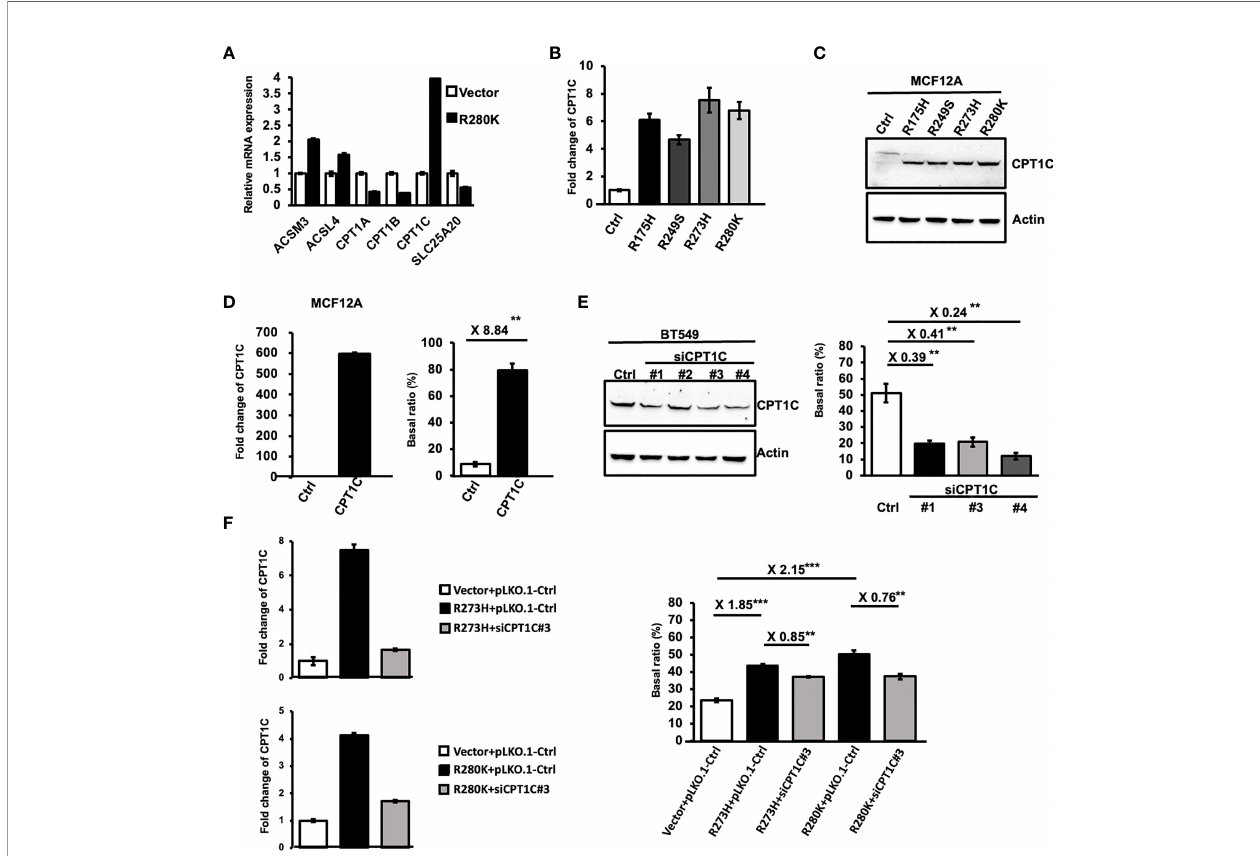
FIGURE 2 | Mutant p53 activates FAO activity through upregulating CPT1C. (A) The differential expression of lipid metabolism-related genes induced by mutant p53. The relative mRNA expression level of ACSM3 , ACSL4 , CPT1A , CPT1B , CPT1C , and SLC25A20 between control and MCF12A-p53 R280K cells were determined by Q-PCR (mean ± SD, n = 3). (B) The mRNA expression of CPT1C is upregulated by p53 hot-spot mutants. Relative mRNA expression of CPT1C between control cells and p53 mutant-MCF12A cells was determined by Q-PCR (mean ± SD, n = 3). (C) Protein expression of CPT1C is upregulated by p53 hot- spot mutants. The expressional levels of CPT1C and Actin in control (Ctrl) and mutant p53-bearing MCF12A cells were examined by Western Blotting. (D) The FAO activity is upregulated by CPT1C overexpression in mammary epithelial cells. Left: The expressional levels of CPT1C and Actin in control (Ctrl) and CPT1C- overexpressing MCF12A (CPT1C) cells were examined by Western Blotting. Right: The FAO activity of Ctrl and CPT1C cells was presented as a Basal ratio and shown as a bar graph (mean ± SD, n = 3). (E) The FAO activity is decreased by the knockdown of CPT1C in BLBC cells. Left: The expressional levels of CPT1C and Actin in control (Ctrl) and CPT1C-KD BT549 cells (siCPT1C#1, #3, and #4) were examined by Western Blotting. Right: The FAO activity of Ctrl and CPT1C cells was presented as a Basal ratio and shown as a bar graph (mean ± SD, n = 3). The two sides of the lines above the bars indicated the comparison of each KD clone to the control, and the value of fold changes with the asterisks representing signi fi cance was marked above the line. Data were analyzed by unpaired t-test. **p < 0.01. (F) Downregulating CPT1C expression interferes with p53 mutant-enhanced FAO activity. Left: The mRNA expressional level of CPT1C in control and CPT1C- KD MCF12A-p53 R273H and MCF12A-p53 R280K cells (siCPT1C#3) were examined by Q-PCR. Right: The FAO activity of Ctrl (Vector+pLKO.1), MCF12A-p53 R273H (p53 R273H +pLKO.1), CPT1C-KD MCF12A-p53 R273H (p53 R273H +siCPT1C#3), MCF12A-p53 R280K (p53 R280K +pLKO.1), CPT1C-KD MCF12A-p53 R280K (p53 R280K +siCPT1C#3) cells were presented as Basal ratio and shown as a bar graph (mean ± SD, n = 3). The two sides of the lines above the bars indicated the comparison of the two groups, and the value of fold changes with the asterisks representing signi fi cance was marked above the line. Data were analyzed by unpaired t-test. **p < 0.01;